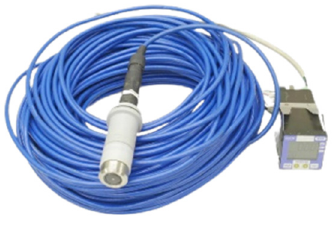
Figure 8. DO sensor.